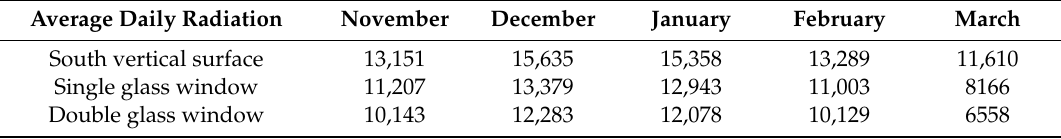
Table A5. The average daily radiation in south vertical surface of buildings in Qian Yang, and its total radiation quantity for glass window (KJ / m 2 · d).